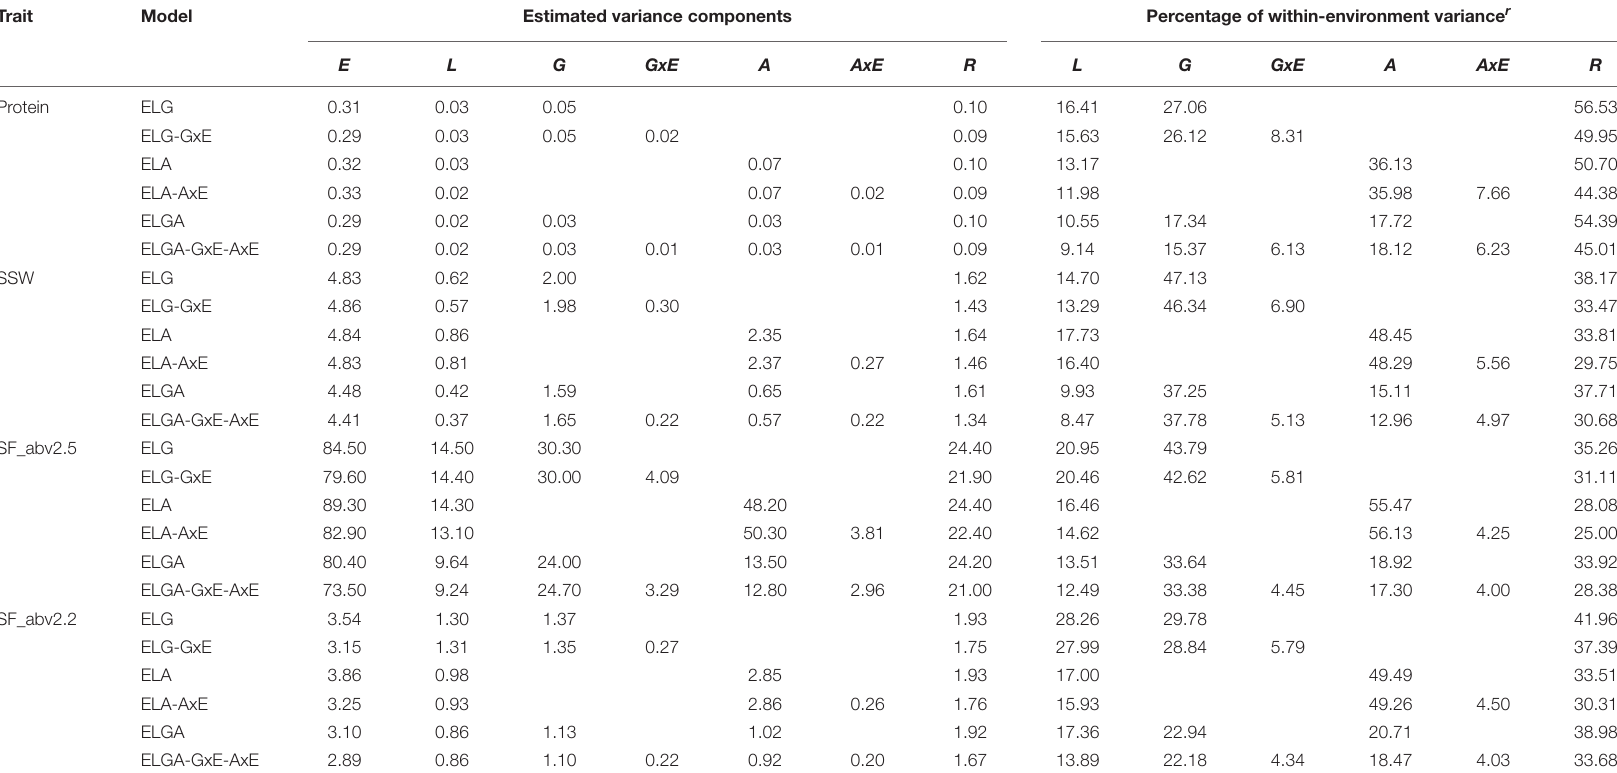
TABLE 3C | Variance components and percentage within-environment variance for random effects in the models with NS data. Trait